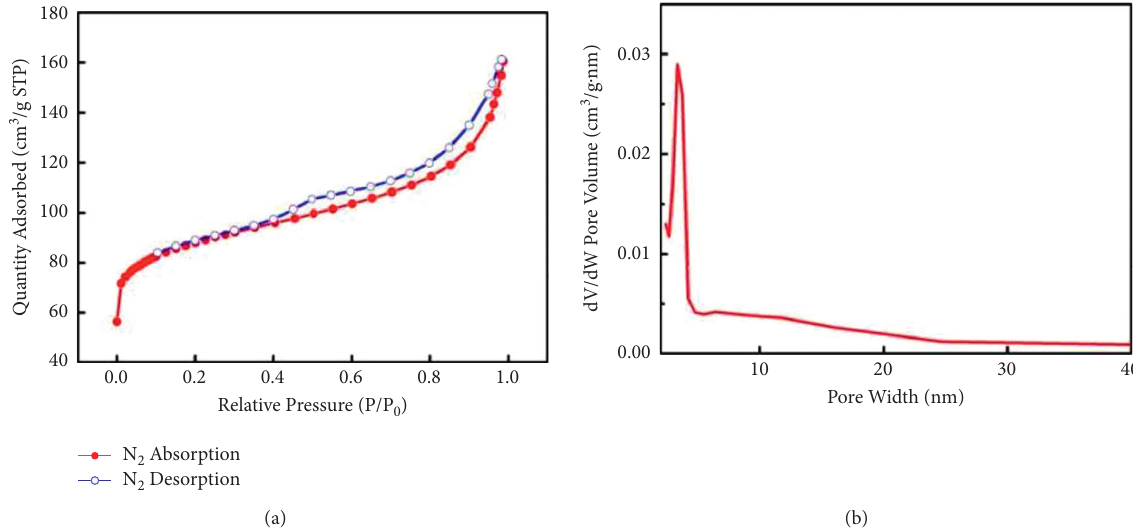
Figure 5: N 2 adsorption-desorption isotherms (a) and corresponding BJH pore size distribution curve (b) of EA-CuHCF.